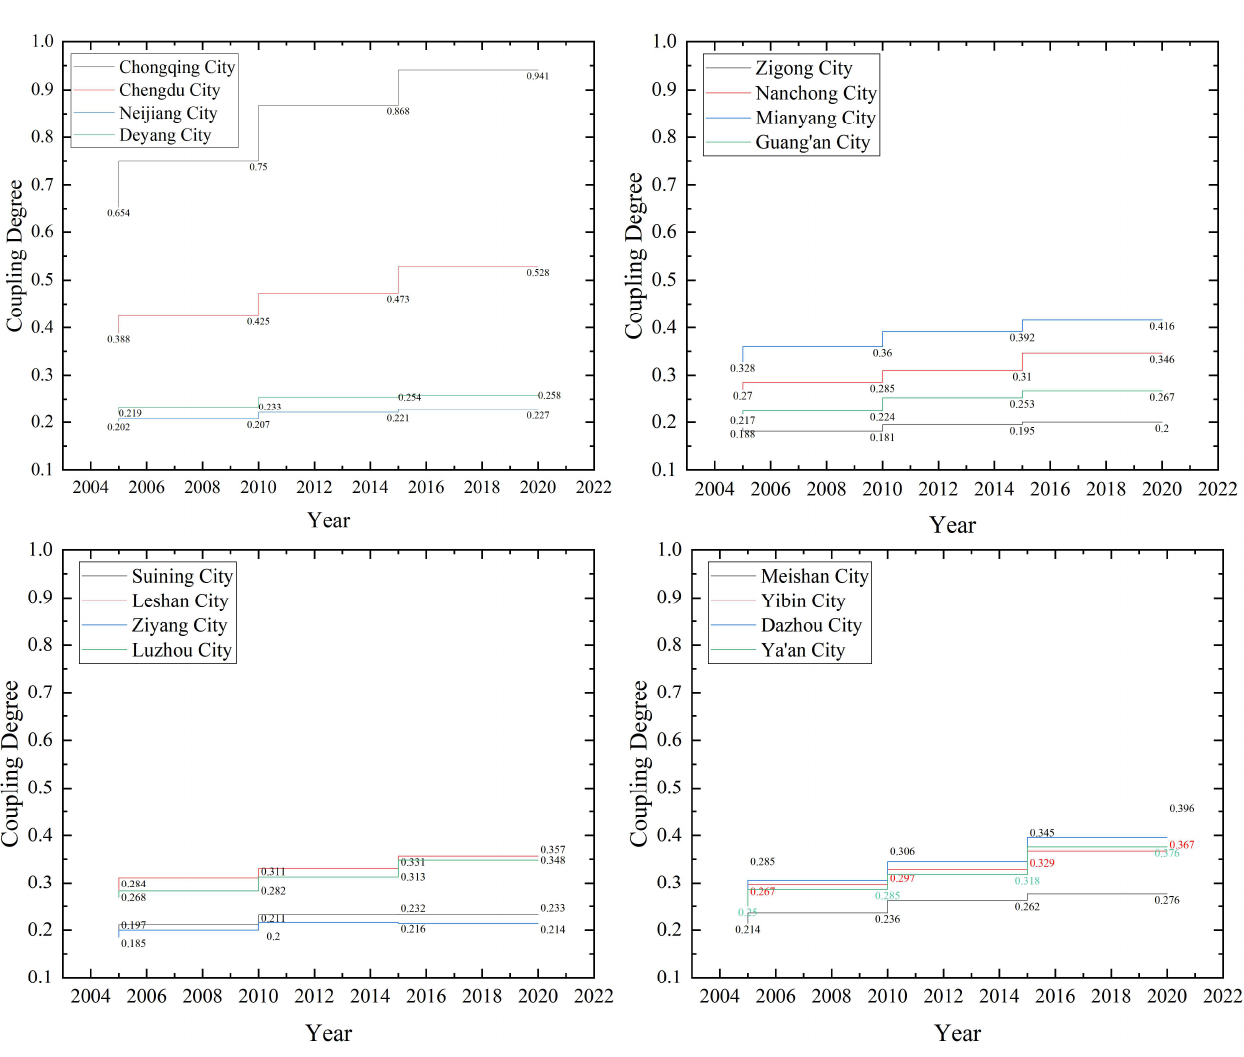
Figure 7. Trend of coupling and coordinated changes in economic–social development and ecological service system in CCCG from 2005 to 2020.